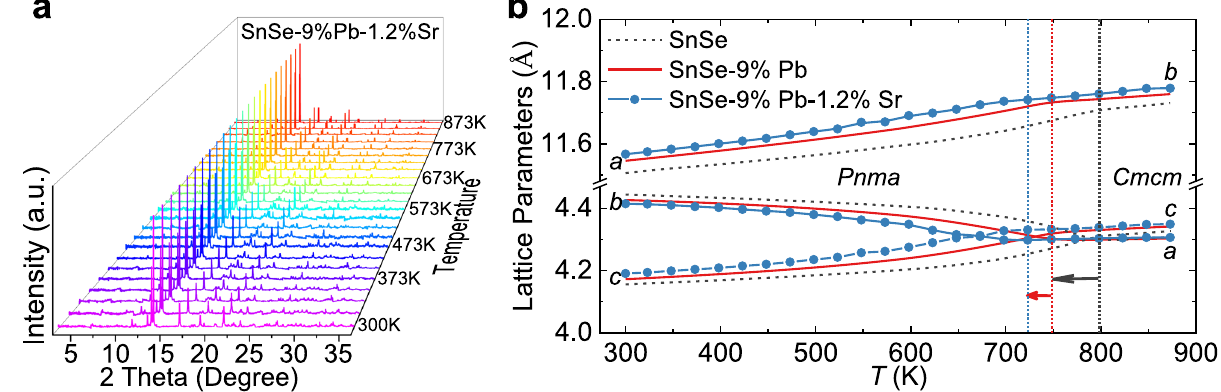
− 1.2%Sr.Thearrowsshowthat T pt declinesfrom~800KinSnSe 44 to~748KinSnSe- 9%Pb 44 and ~723K for SnSe-9%Pb − 1.2%Sr, indicating that Sr alloying further pro- motes the phase transition of